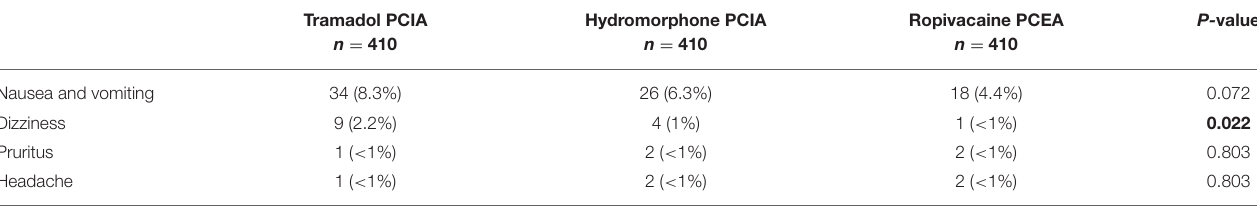
TABLE 5 | Adverse events in the three postoperative analgesia